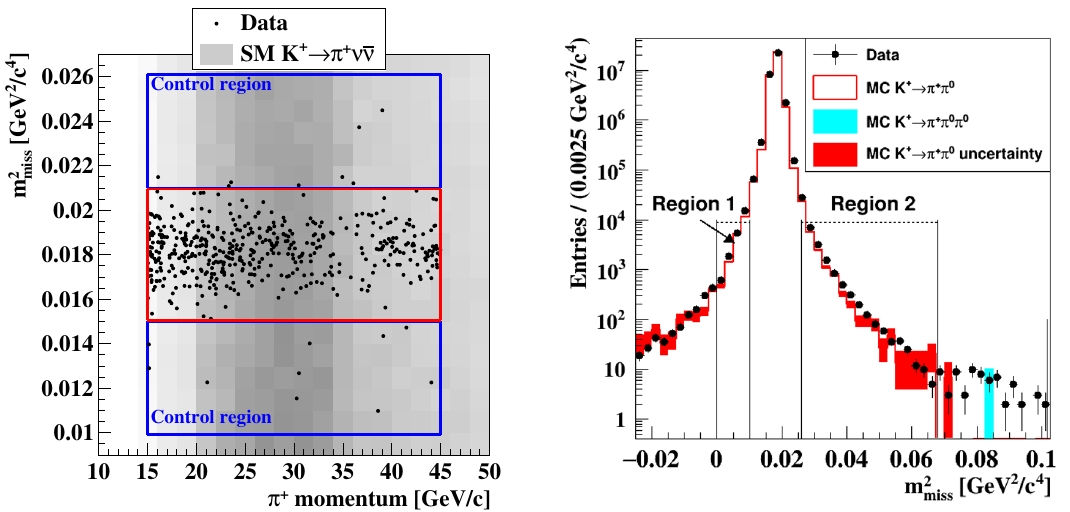
, m 2 ) plane of π miss distribution miss kin